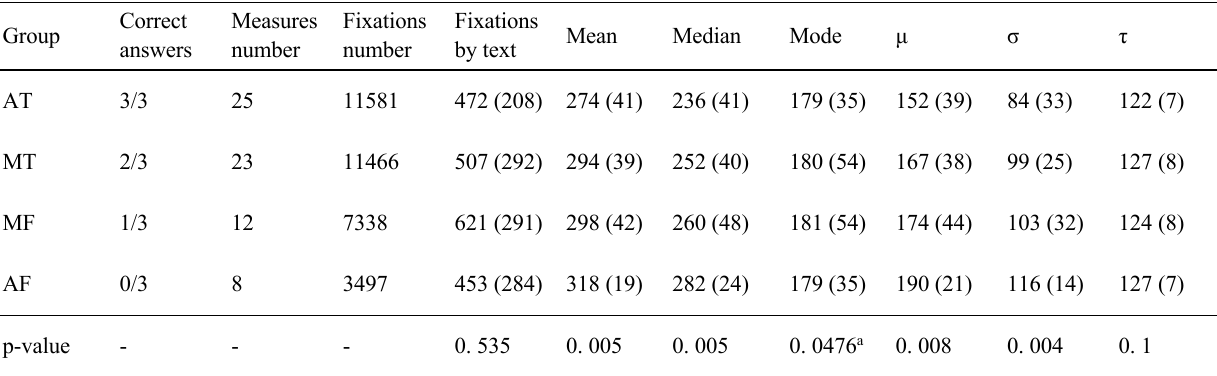
Table 2. Ex-Gaussian parameters by answers group for fixation durations in reading.